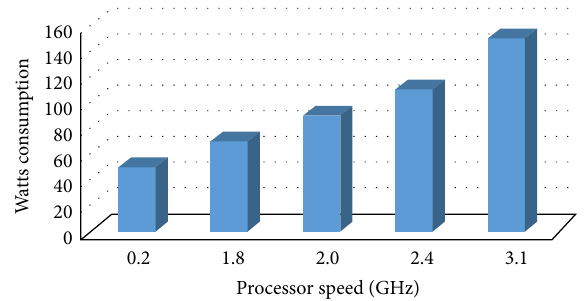
Figure 3: Standard Watts consumption of different processors.